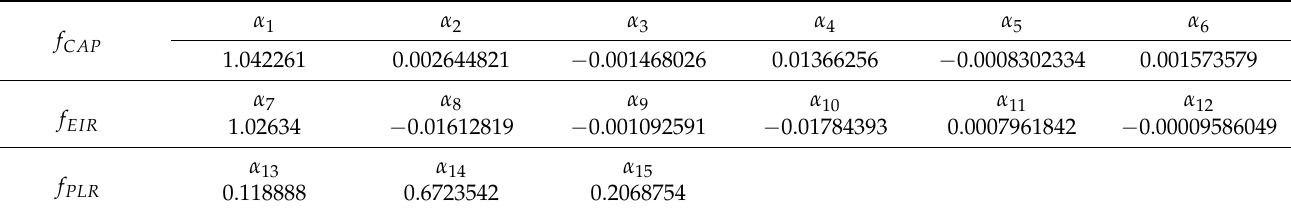
Table 4. Water-cooled chiller model